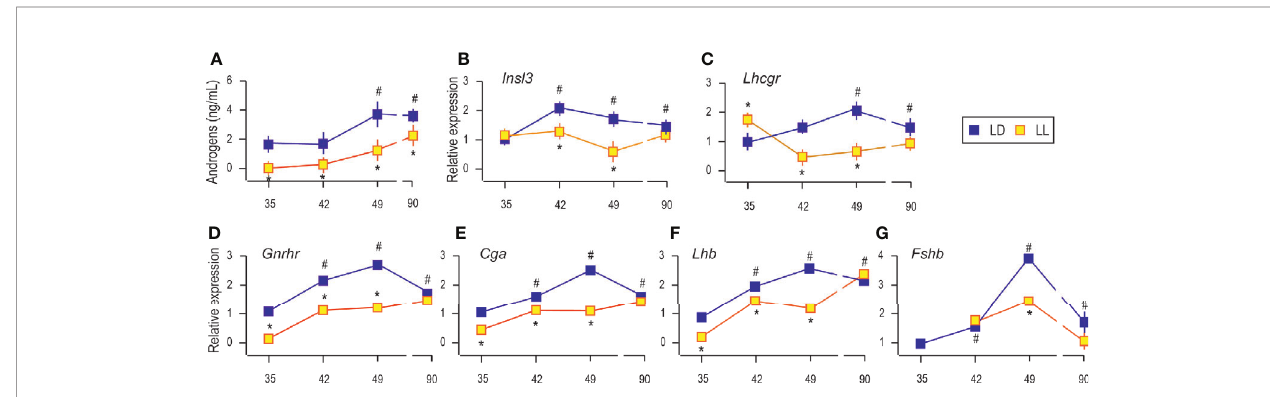
FIGURE 2 | Growing up under constant light reduced serum androgens, changed transcriptional pattern of Leydig cells ’ maturity markers and genes encoding pituitary gonadotropic hormones. Androgen levels were monitored in serum from rats that lived in LD or LL regime (A) . At a certain age Leydig cells were puri fi ed, RNA isolated, and qRT-PCR performed in order to measure expression of genes markers for Leydig cells ’ maturity/activity (B, C) . The RNAs were isolated from the pituitary of both groups, and the expression of genes encoding GNRHR (D) as well as subunits of gonadotrophic hormones (E – G) was measured. Data points represent group means ± SEM values (n = 5 – 8). *Statistical signi fi cance at level p < 0.05 compared to the corresponding LD group; # Statistical signi fi cance at level p < 0.05 compared to the P35 LD